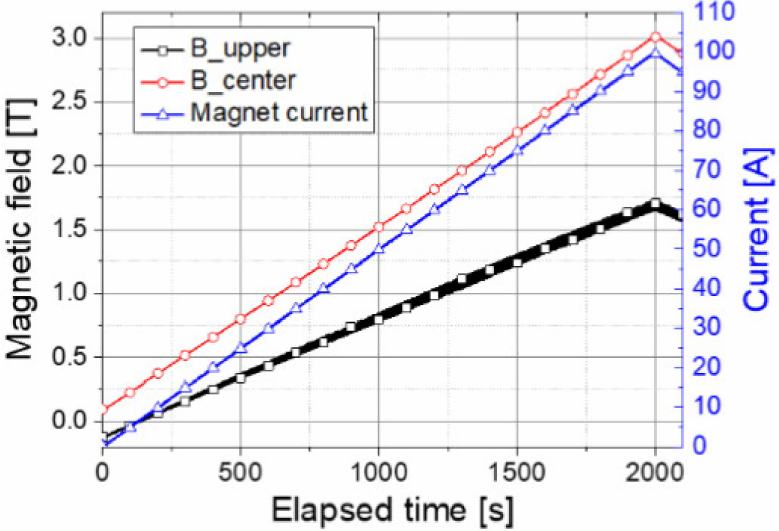
Figure 9. Second charging test results of the 3 T magnet